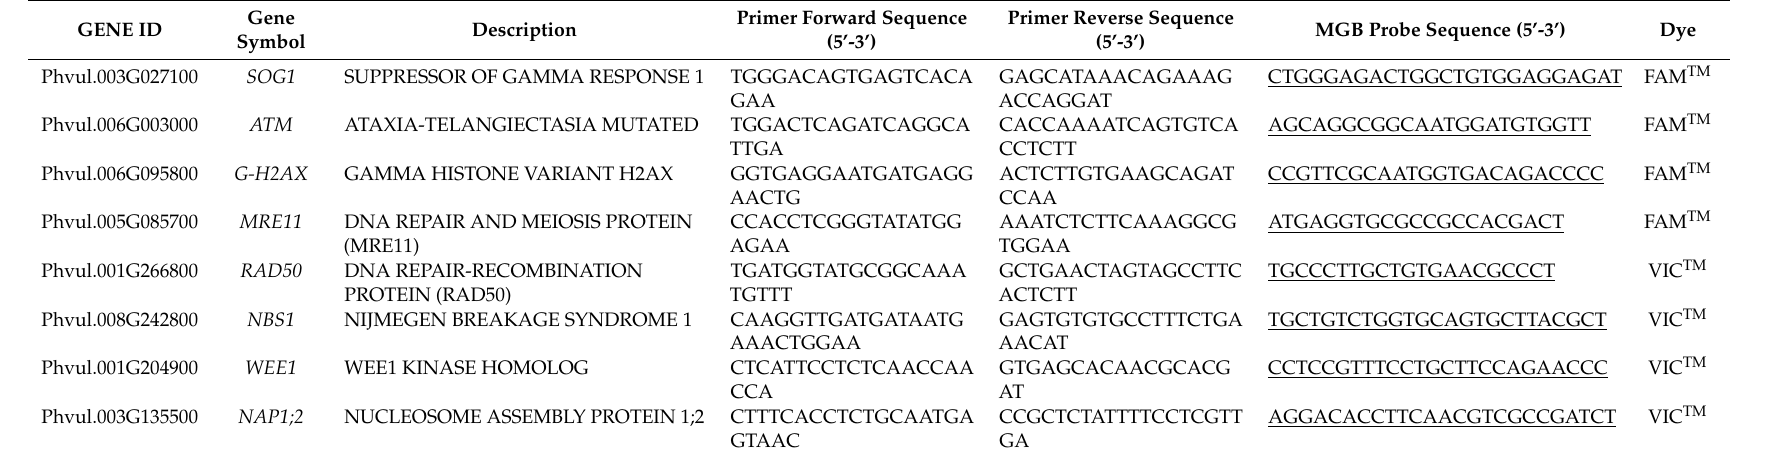
Table 1. List of selected genes and description of the primers and probes constructed to be used for digital